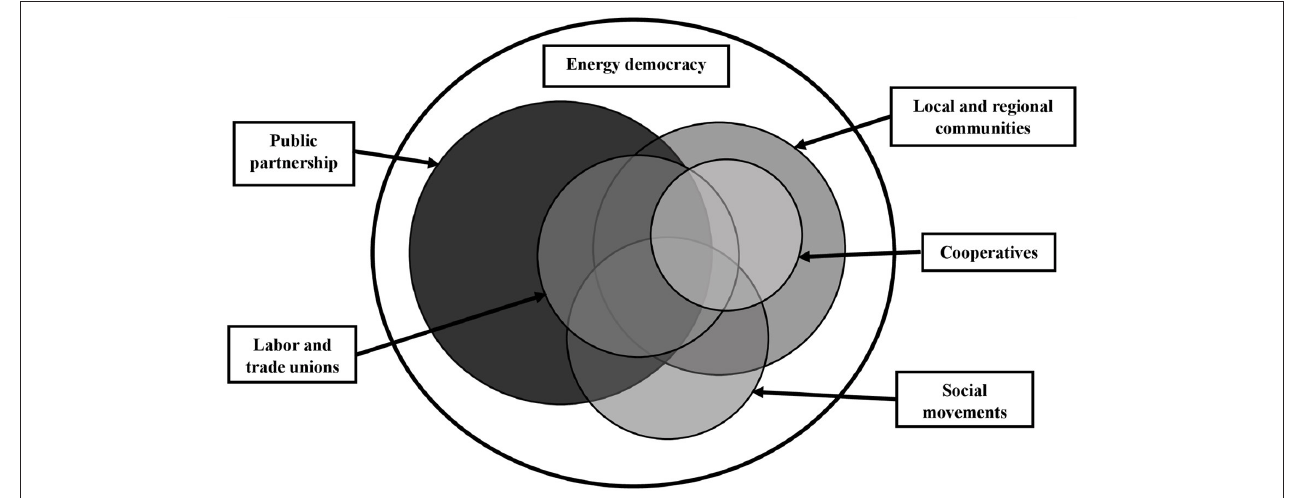
FIGURE 1 | Visualizing diverse types of energy democracy across the region.